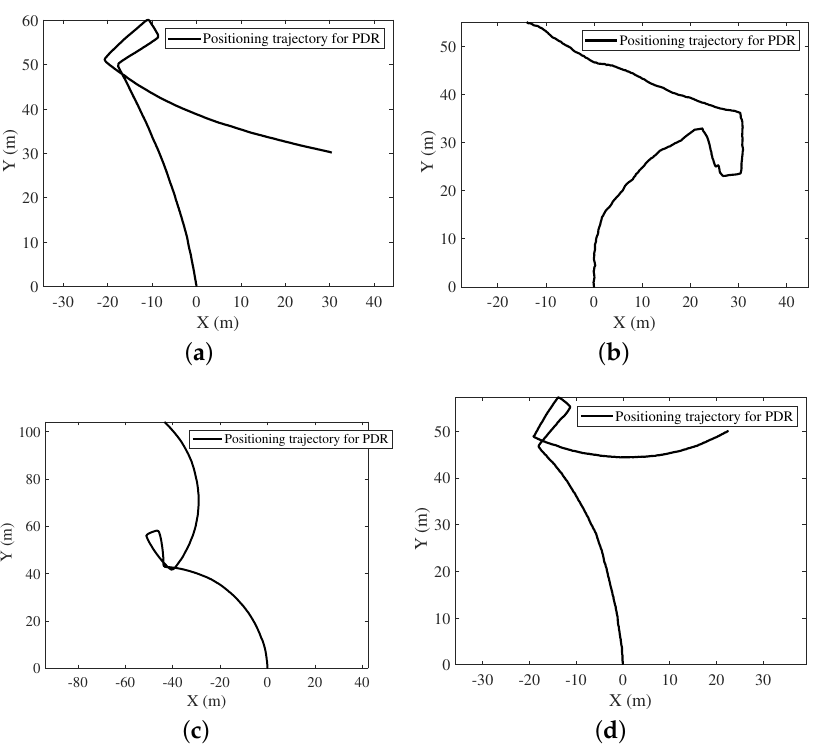
Figure 9. Navigation trajectories for PDR. ( a ) Calling mode. ( b ) Dangling mode. ( c ) Handheld mode. ( d ) pocketed mode.